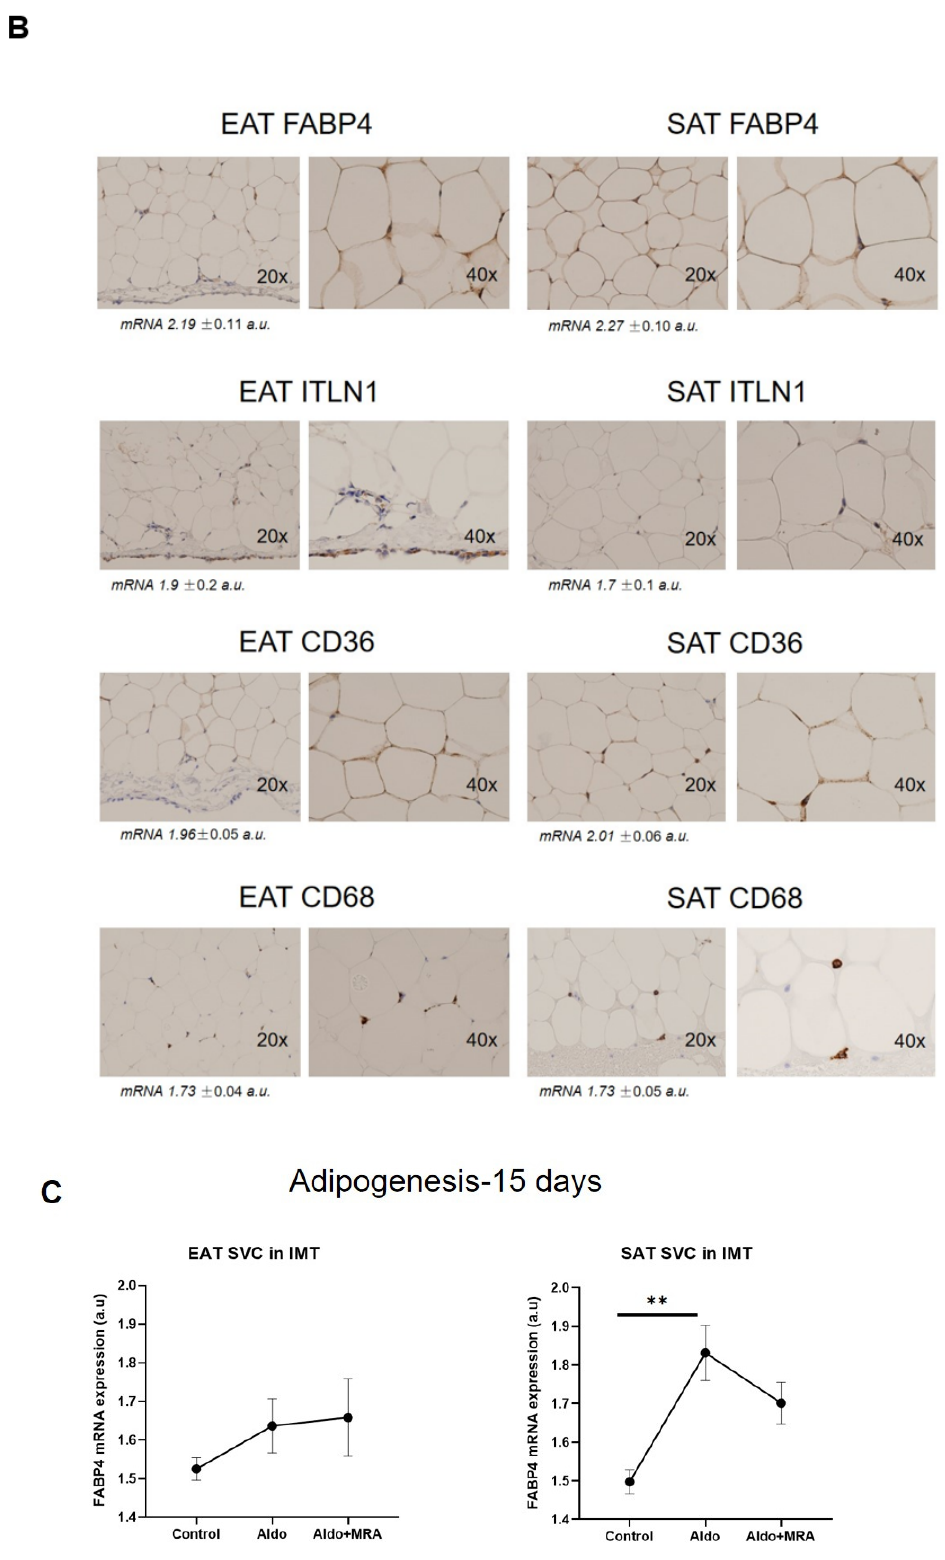
Figure 2. Cell-RNA expression level fat pads ( A ) Hierarchical clustering heatmap represents the mRNA expression levels (a.u.) of genes in epicardial (EAT) and subcutaneous (SAT) fat from patients with cardiovascular disease. ( B ) Immunohistochemistry of EAT and SAT with antibodies against FABP4, ITLN-1, CD36, and CD68 (objective magnification, × 20 and × 40). In numbers, under the immunohistochemistry, the mean ± SD mRNA expression levels of the total analysed biopsies